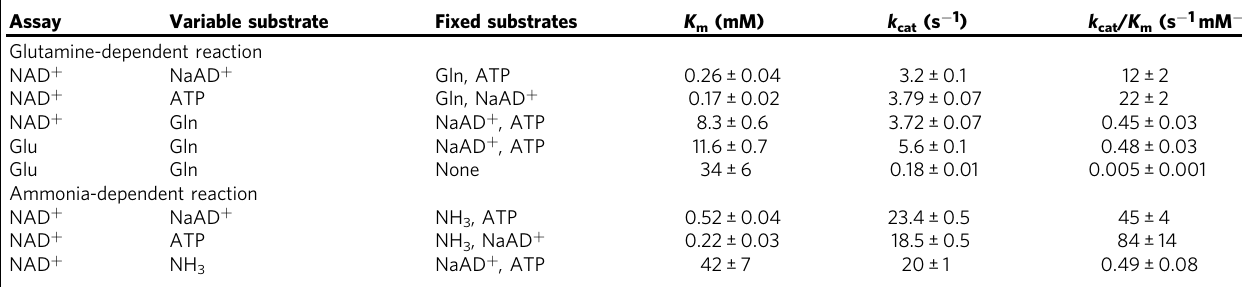
Table 1 Steady-state kinetic parameters of the hsNadE catalyzed reactions. Assay